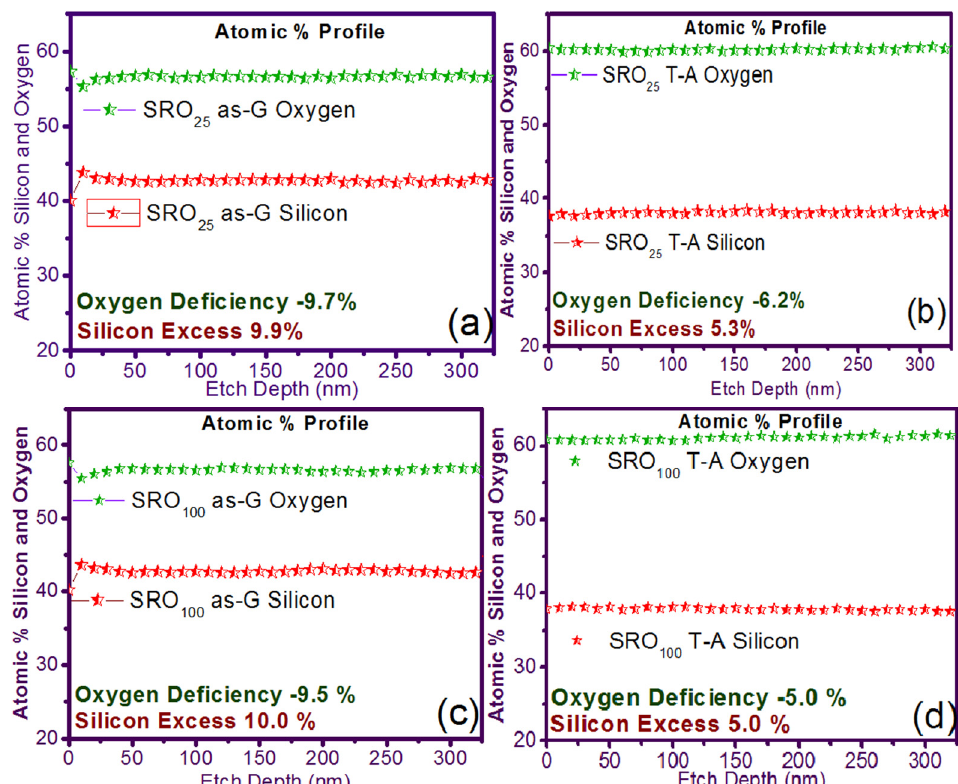
Figure 1. Silicon excess and oxygen deficiency for the case of simple layer (S-L) silicon-rich oxide (SRO) films ( a ) SRO 25 as-grown (as-G), ( b ) SRO 25 thermal annealing (T-A), ( c ) SRO 100 as-G, and ( d ) SRO 100 T-A.